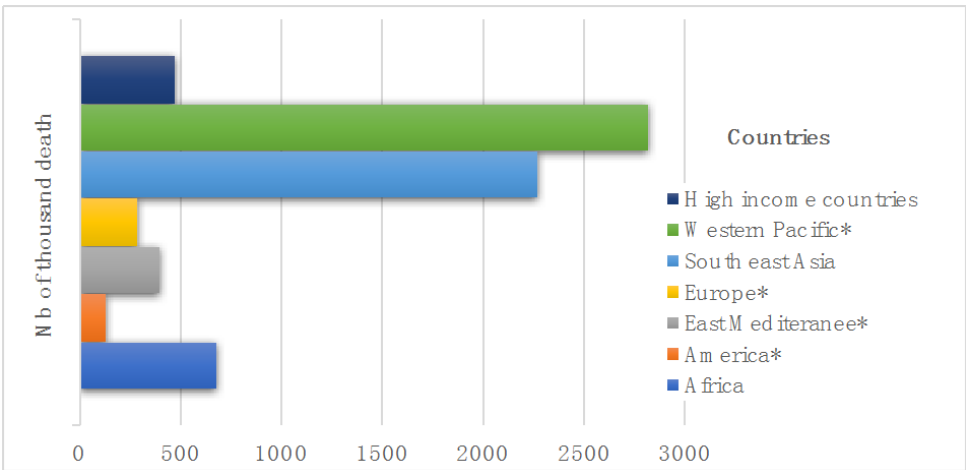
Figure 1 . According to the world health organization (WHO), air pollution is now one of the world’s largest health risks when excluding communicable diseases; deaths attributable to joint effects of both household and ambient air pollution [5]. * Low and middle income countries.